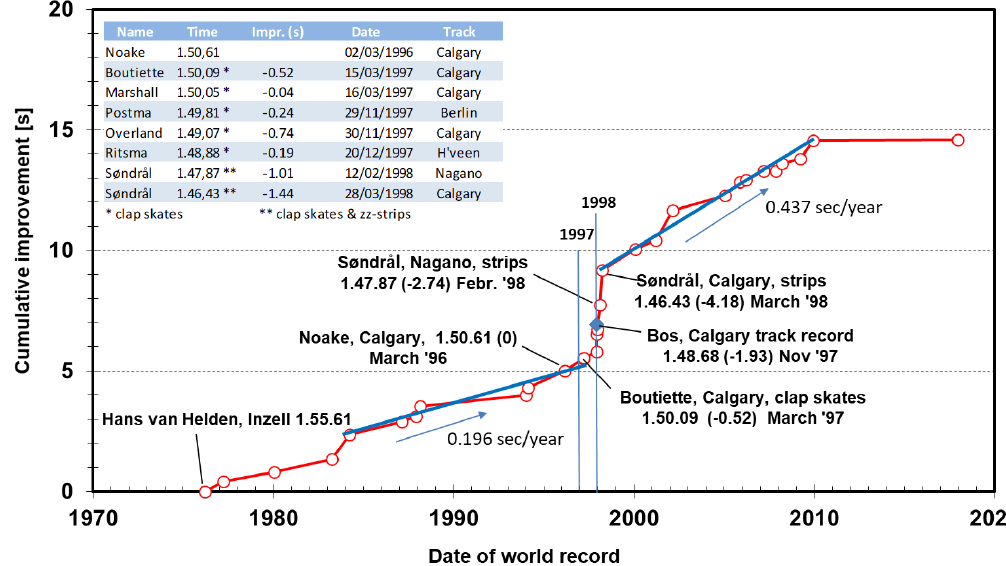
Figure 12. Cumulative improvement in seconds of the 1500 m world record for men since 1976.